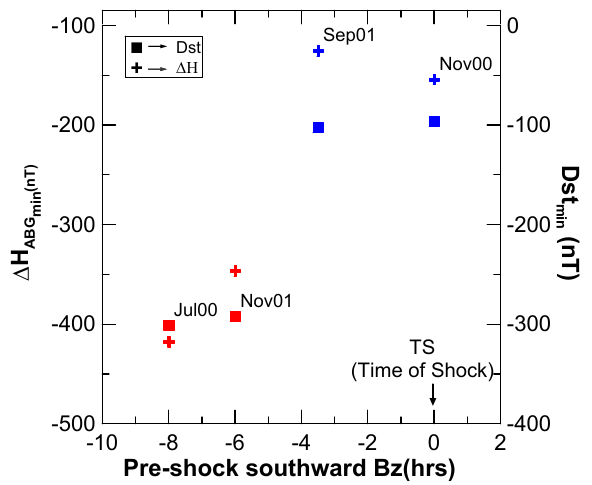
Fig. 17. Illustrates correspondence of 1H ABG minimum (filled “+” signs) with a duration of southward B z before shock and D st min (filled square symbols) for four SEP events. “TS” indicates the shock time. The pre-shock hours with southward IMF B z are marked with respect to the shock time. Red colour symbols depict two intense main phase events of July 2000 and November 2001. For intensity of these storms, see the degree of depression in the Alibag magnetic field and high level of auroral activity. Weak main phase events of November 2000 and September 2001 have been shown by blue symbols. These two cases can be identified by lower values of 1H ABG minimum and AE